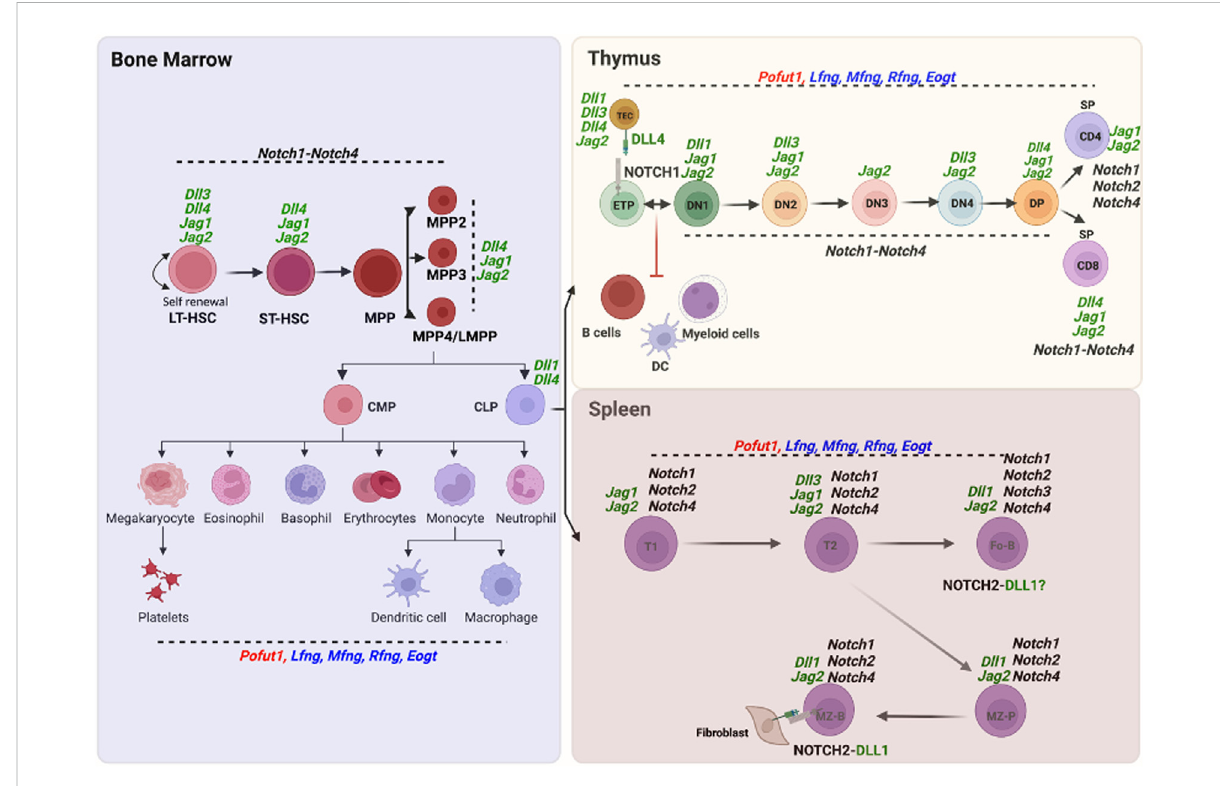
FIGURE 3 Expression of O-glycan glycosyltransferase, Notch receptor and Notch ligand genes in hematopoietic cells. Expression of the O-glycan glycosyltransferase, Notch receptor and canonical Notch ligand genes whose deletion causes developmental changes in lymphopoiesis and myelopoiesisareshownincellsofthethreehematopoieticcompartments-bonemarrow, thymusandspleen-basedondatafromsingle cellRNA- seq or microarray experiments reported in the ImmGen Skyline database (http://rstats.immgen.org/Skyline/skyline.html). NOTCH1 in ETP and DLL4 in thymic stroma, as well as NOTCH2 in MZ B and DLL1 in splenic stroma, are also shown as